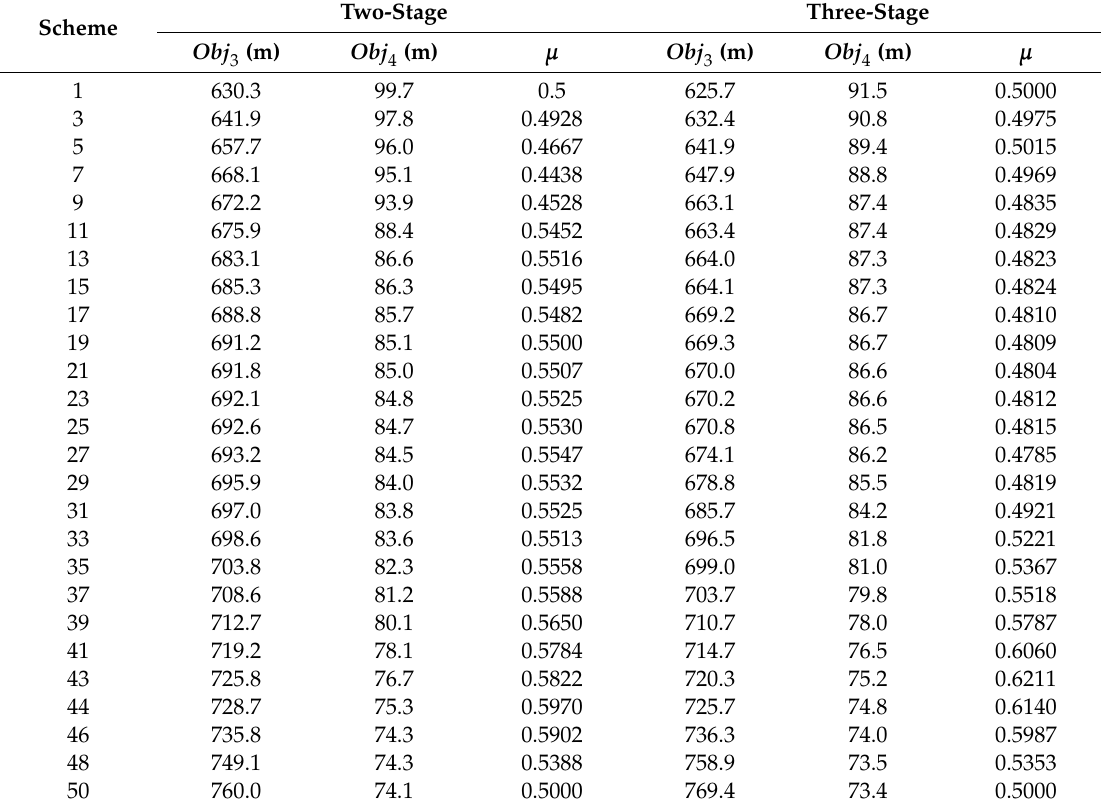
Figure 18. Comparison of optimized closing schemes in Case 3 for (a) guide vanes and ( b ) ball valve. Table 5. Partial Pareto optimal solutions by different closing operations.